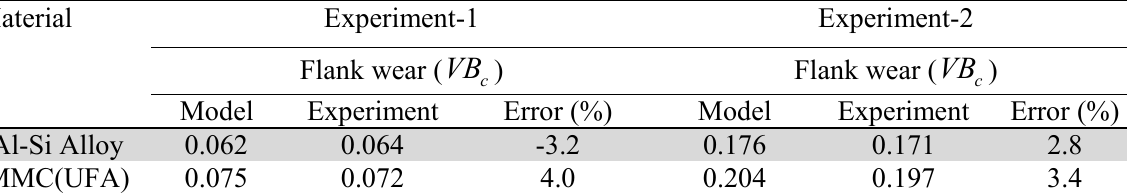
Results of the confirmation test for tool wear Material Experiment-1